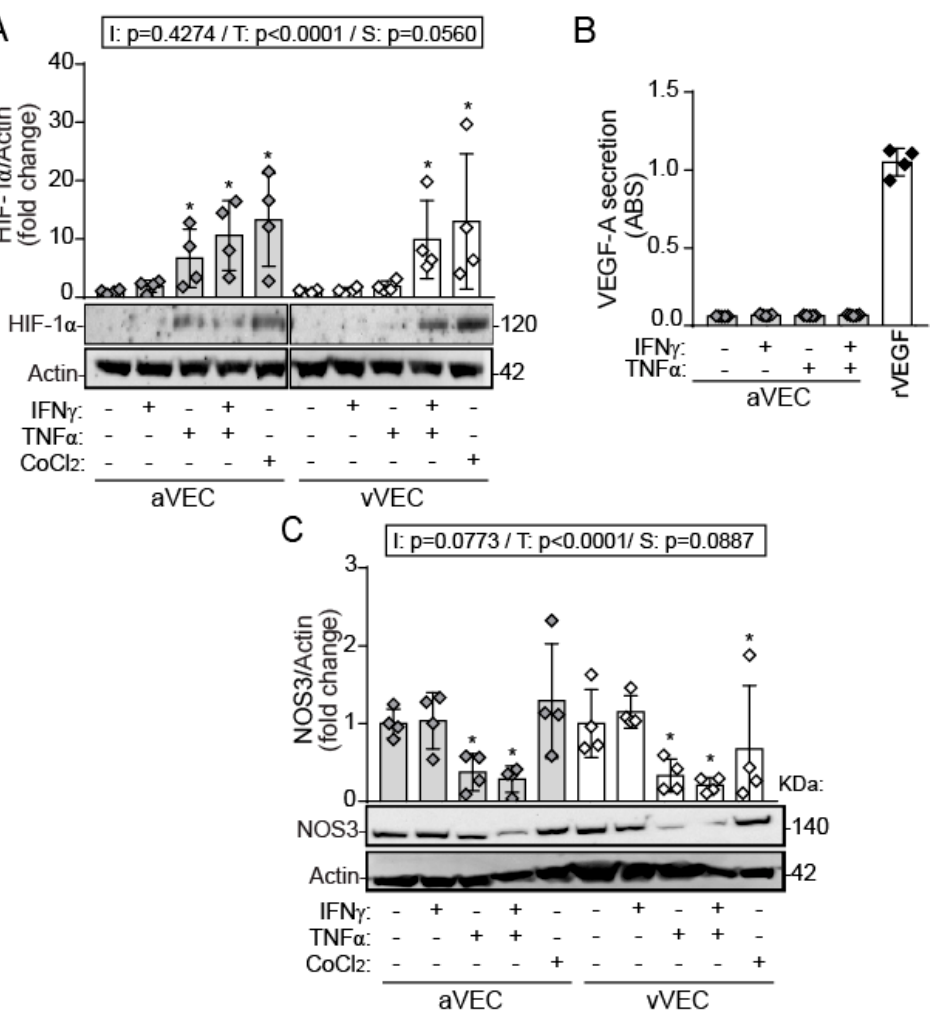
Figure 3. TNF- α but not IFN- γ , promoted the immune induction of HIF-1 α , as well as NOS3 protein downregulation in side-specific VEC. ( A – C ) aVEC and vVEC were sheared for 48 h and then treated with the indicated ligands for 24 h. ( A ) Whole cell extracts were analyzed by Western blot for HIF-1 α expression. Densitometry analysis and representative blot of n = 4 aVEC and vVEC pairs from independent valve donors. Cropped images are from the same membrane and were processed in parallel. ( B ) Supernatants from activated aVEC were analyzed to assess VEGF-A secretion. ABS indicates raw absorbance at 450 nm. ( C ) Whole cell extracts were analyzed by Western blot for NOS3 expression; n = 4 pairs. Grey diamond and bars, aVEC; white diamond and bars, vVEC. CoCl 2 indicates 100 µM cobalt chloride; IFN γ , 100 ng/mL IFN- γ ; rVEGF, recombinant VEGF-A; TNF α , 5 ng/mL TNF- α . Datasets A–C: Mean ± S D. 2-Way ANOVA statistics are shown above the graph; I = interaction between treatment and valve side; T = treatment; S = valve side. * p < 0.05 compared to the control group (Dunnet test).